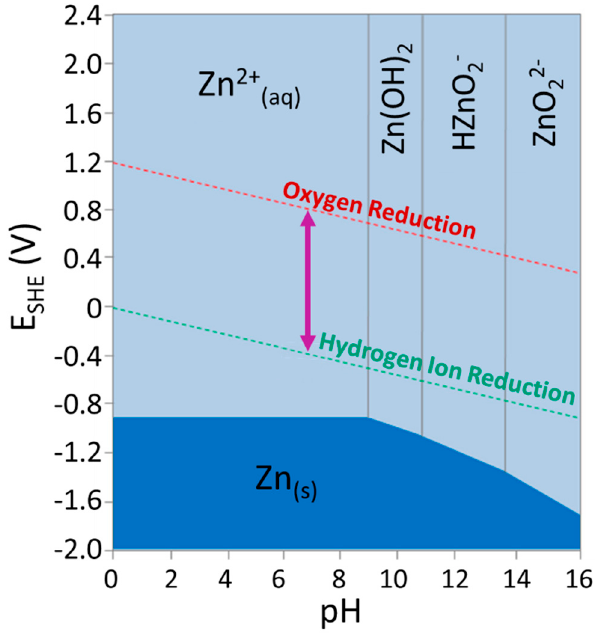
Figure 2. Pourbaix diagram of zinc. The purple arrow shows the range of biological standard reduction potentials at pH 7.4: from ~820 mV to ~ − 670 mV [66]. potentials at pH 7.4: from ~820 mV to ~ − 670 mV